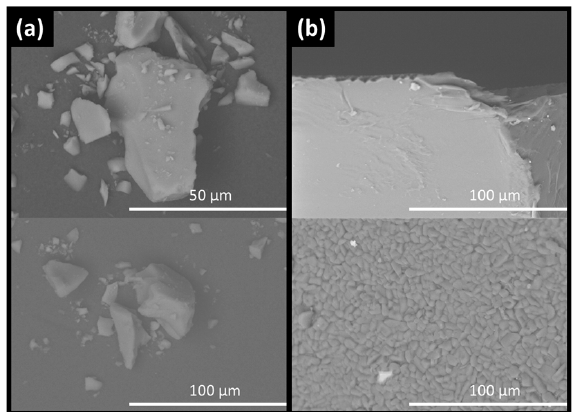
morphologyat0days(top)and90daysstability(bottom)asspecifiedinthematerialsandmethodssection.